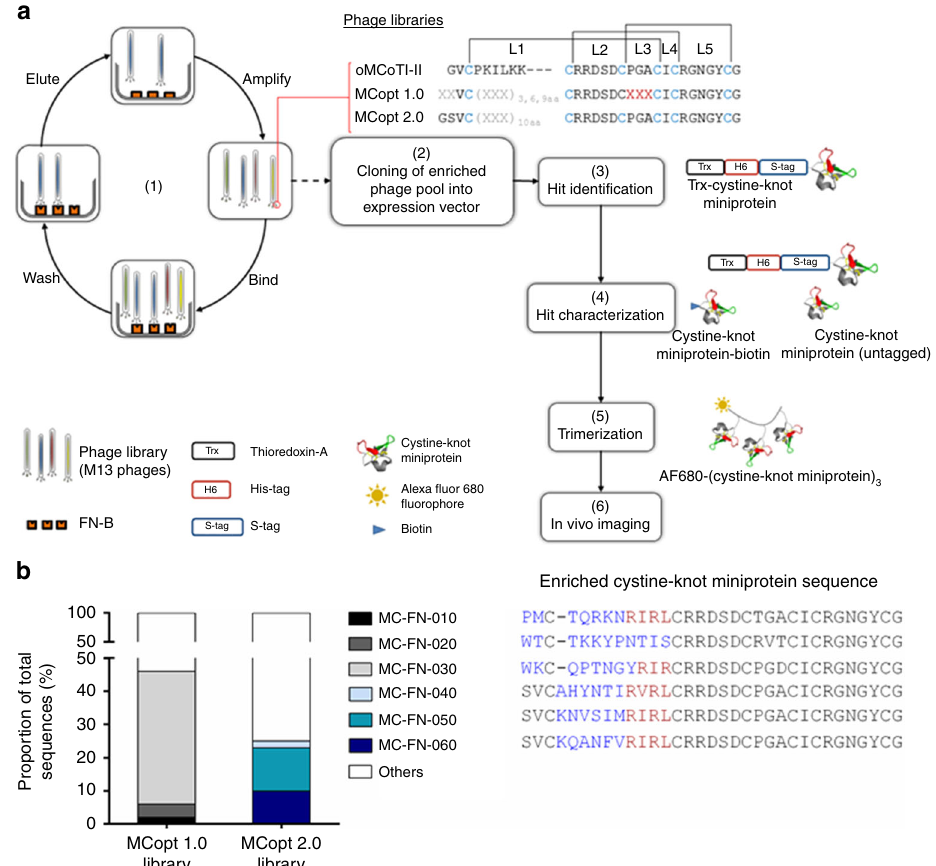
Fig. 1 Enrichment of clones with a common sequence motif by library screening against EDB. a EDB-speci fi c ligand selection and development of an imaging agent. (1) Three successive rounds of screening of MCopt 1.0 and MCopt 2.0 phage libraries (both based on the oMCoTI-II sequence framework) were performed against a hexahistidine (H6)-tagged single EDB-domain (FN-B) fragment. Disul fi de bonds (brackets) between cysteine residues (blue), randomized positions for any random amino acid except cysteine (X in gray), and amino acid substitutions to 50% (X in red) are indicated. L1 to L5 represent the loop positions. (2) Cystine-knot miniprotein sequences were cloned into expression vector for Trx-cystine-knot miniprotein production. (3) Hit identi fi cation of individual clones was performed by ELISA-based binding analysis (Trx-cystine-knot miniprotein), determination of expression rate, and sequencing. (4) Hits were characterized with regard to af fi nity (with untagged cystine-knot miniprotein), speci fi city (Trx-cystine-knot miniprotein, cystine- knot miniprotein-biotin), and functionality (Trx-cystine-knot miniprotein). (5) Trimerization of lead cystine-knot miniprotein candidates and Alexa Fluor 680 fl uorophore conjugation was performed to allow (6) imaging of tumor vasculature in vivo in a mouse model xenografted with a human glioblastoma cell line. b Enrichment of cystine-knot miniprotein sequences after three screening rounds of phage display libraries MCopt 1.0 and MCopt 2.0. Variable amino acids (blue letters) and the common R-I/V-R-(L) motif (red) are